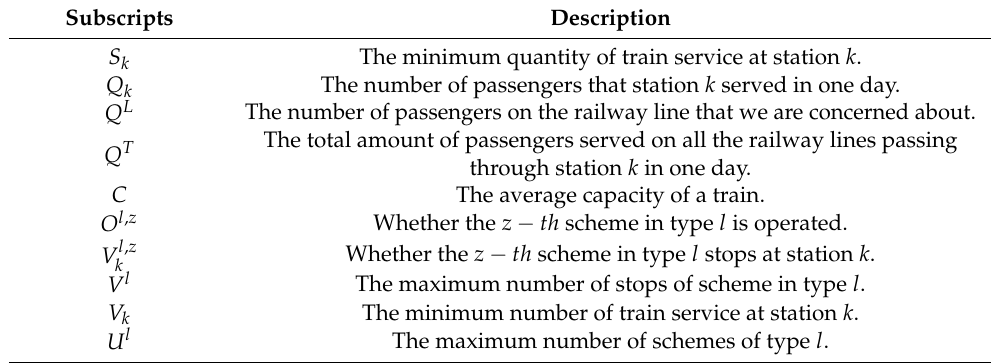
Table 4. Description of the parameters.